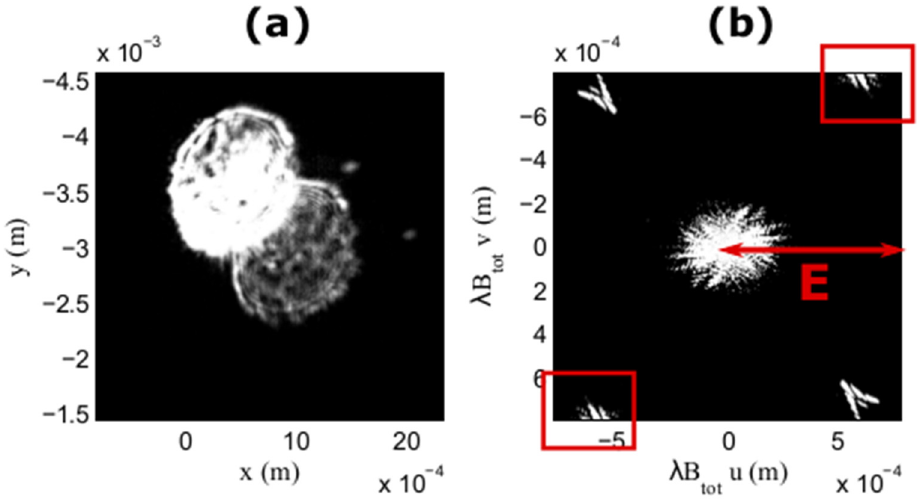
Figure 8. Overlapping out-of-focus images of two nearby ice particles inducing Moiré effects ( a ) and the two-dimensional Fourier transform of the speckle-like pattern (presented in ( a )) ( b ). The number of grey levels has been reduced in this figure ( a ) to enhance the contrast, but all analyses were made with the original images.